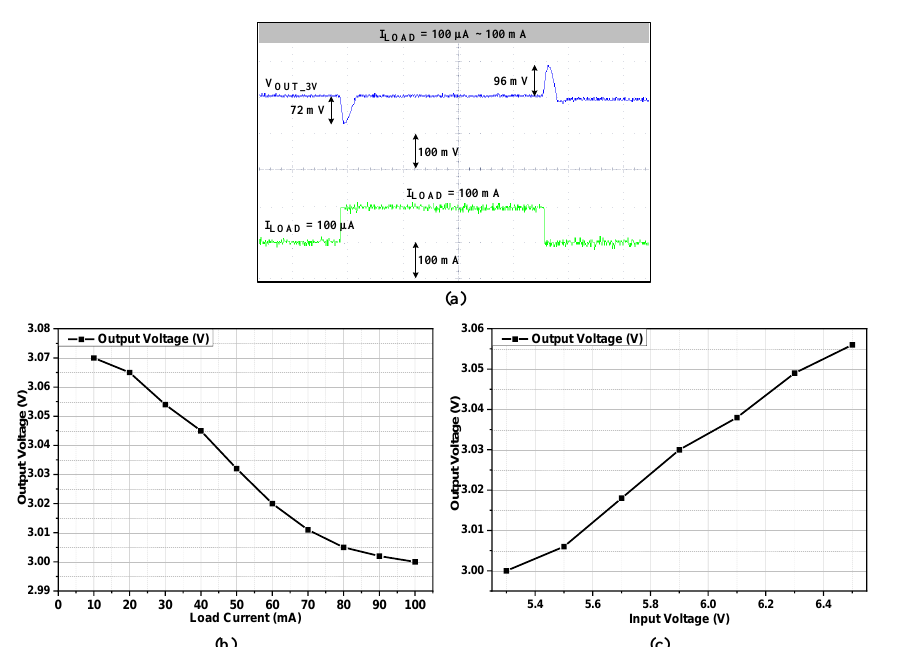
Figure 9. Measured results of LDO_3V. ( a ) Load transient response from 100 µ A to 100 mA. ( b ) Load regulation. ( c ) Line regulation.